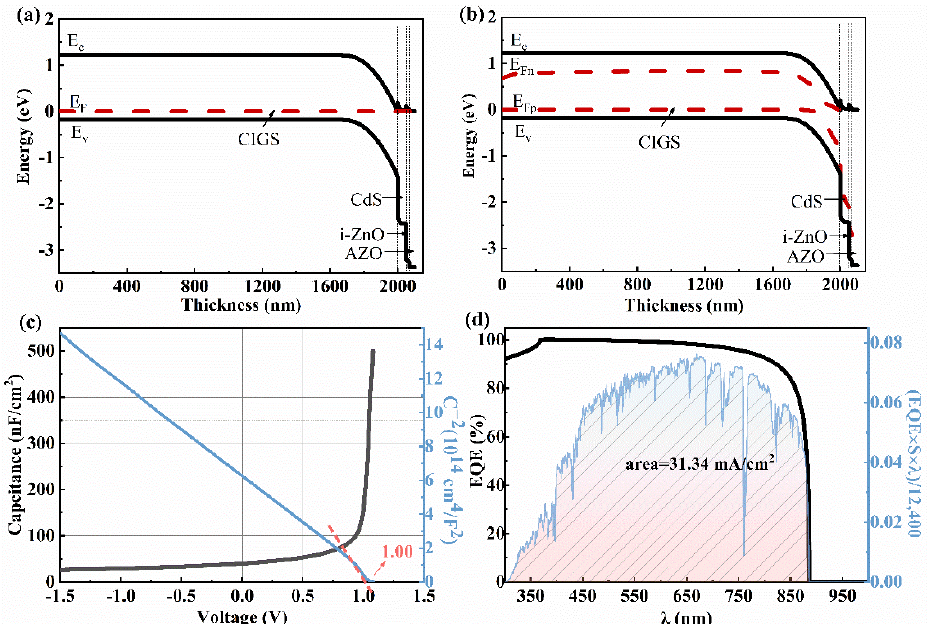
Figure 4. Energy band diagram of the CIGS ( E g = 1.4 eV) solar cell with a device structure of Mo/CIGS/CdS/i-ZnO/AZO under ( a ) dark and ( b ) AM1.5 G light illumination. ( c ) C - V and C −2 - V curves, ( d ) EQE curve and the J sc value from the integral curve based on the expression EQE × S × λ a wavelength of sunlight; S is the standard AM1.5 G spectrum. Table 2. The simulated device parameters for PV devices with different device architectures.